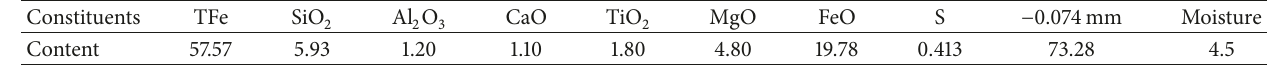
Table 1: Physical and chemical analysis of the iron concentrate (%).